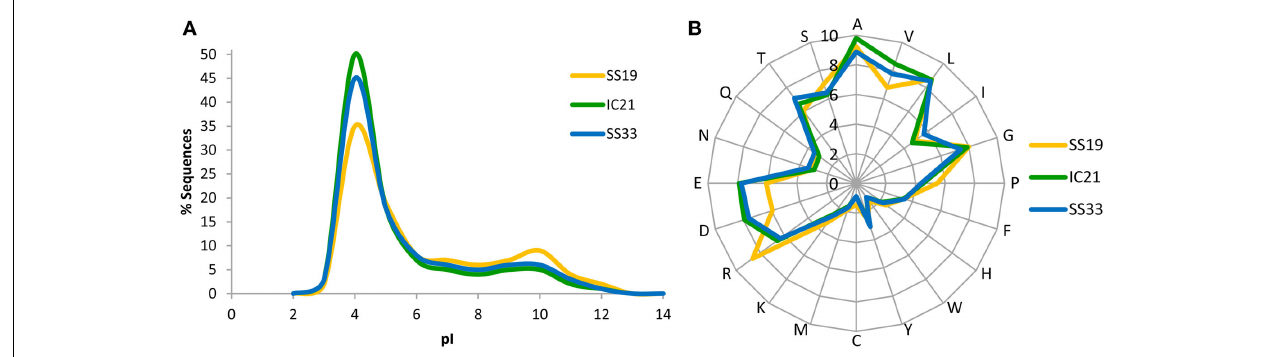
FIGURE 2 | Isoelectric point (pI) profiles (A) and amino acid frequency (B) of the predicted proteins in the metagenomic datasets SS19, IC21, and SS33. The pI was computed for each translated read and is shown as a percentage of the dataset in intervals of bin width 2.